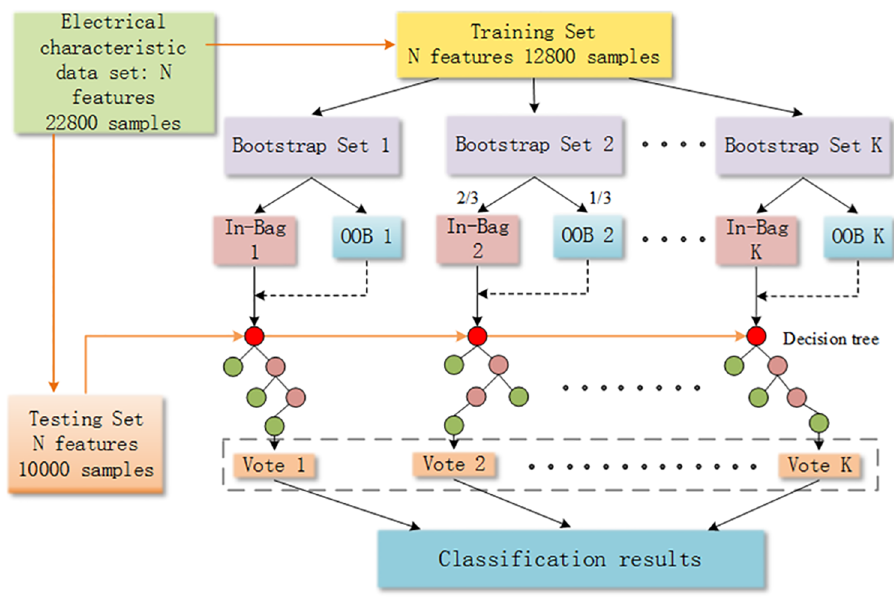
Fig 7. The structure of random forest algorithm. The random forest is composedof the generatedtrees, and we use the random forest to classify the electricalsignal test data. The classificationresult is decidedby the decisiontrees. The structure of the randomforest algorithmused in our article is shown in Fig 7.